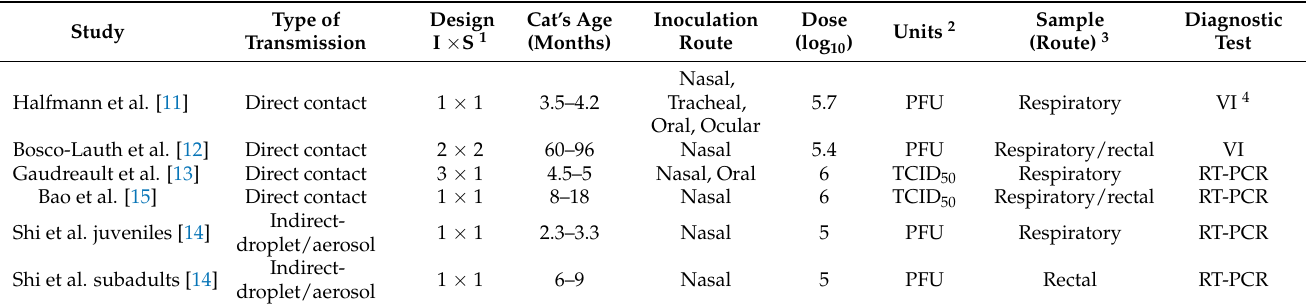
Table 1. Summary of the experimental procedures showing the study design, the age of the cats, the inoculation route and dose, the type of samples taken and the diagnostic method used to quantify virus levels in time.